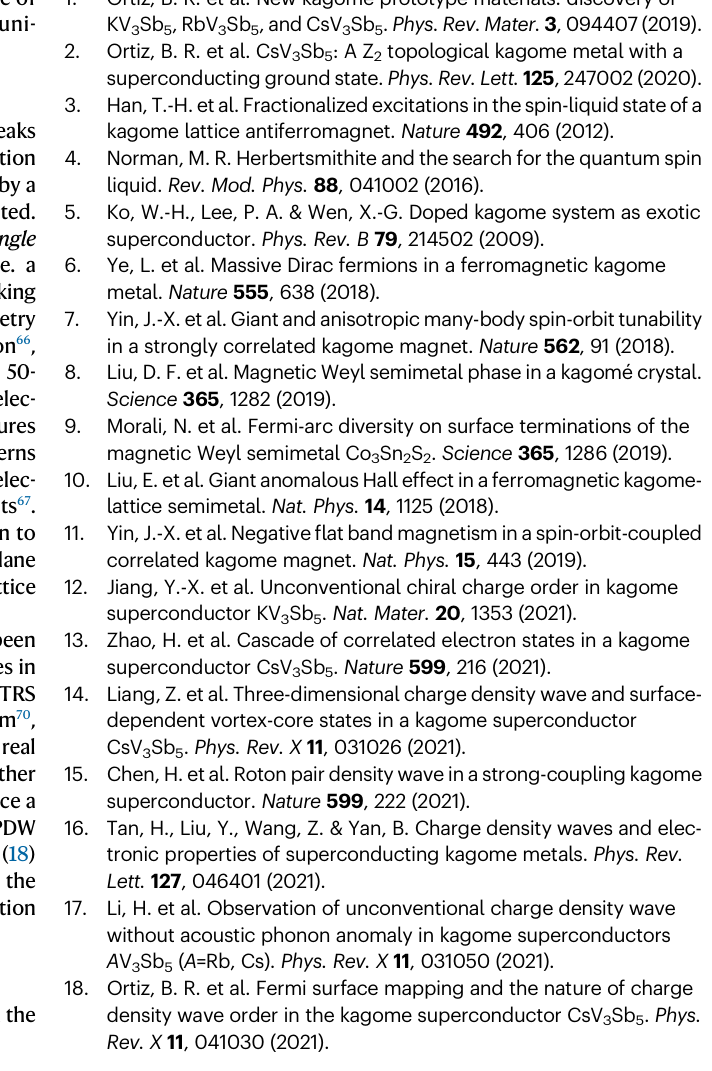
The bands of the 2 a 0 ×2 a 0 PDW are folded into the 4×4 reduced BZ for the convenience of